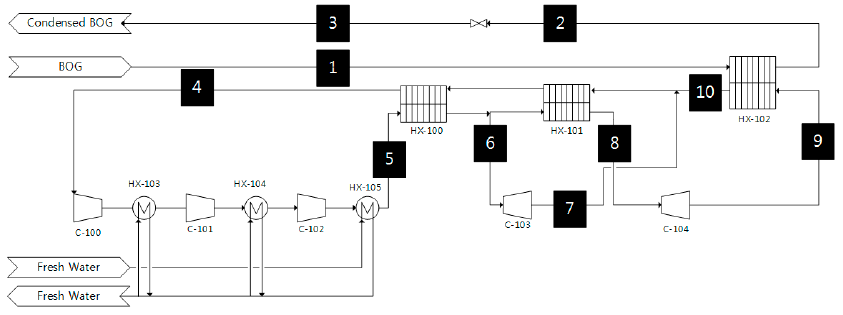
Figure 1. Process flow diagram of System I.